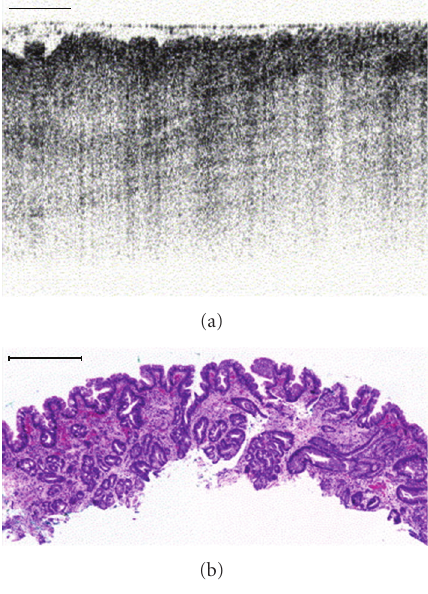
Figure 6: Endoscopy of UH-OCT. The upper image is the OB and the lower image shows the histology of the area. (Taken from P. Hsiung, L. Pantanowitz, et al. (2005) http://www.med.upenn.edu/ bmbgrad/Program/course descriptions/BMB 620/10212005 chen